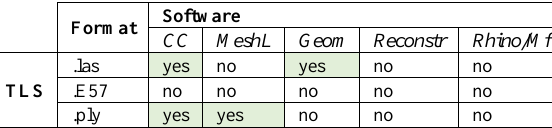
Table 4. Interoperability: Terrestrial Laser Scanner FARO CAM2 Focus